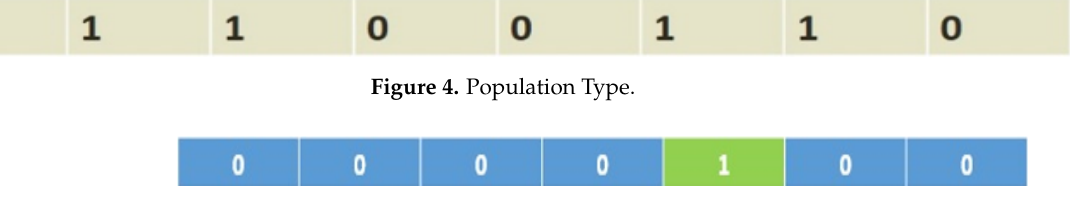
Figure 5. Bid selection structure in Binary